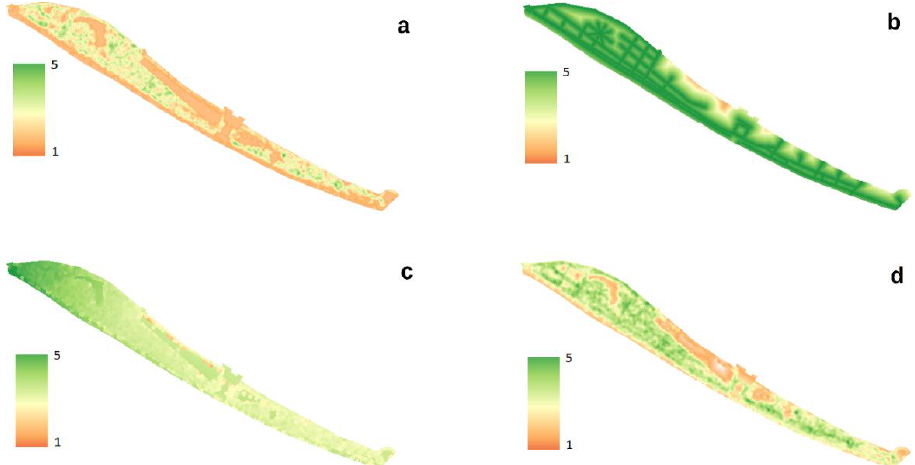
Figure 4. Perception of natural sounds ( a ), perception of people-related sounds ( b ), Willingness to Visit (visual perception) ( c ), Willingness to Visit (integrated perception) ( d ). U.M.: 5-points Likert scale. Source: Own